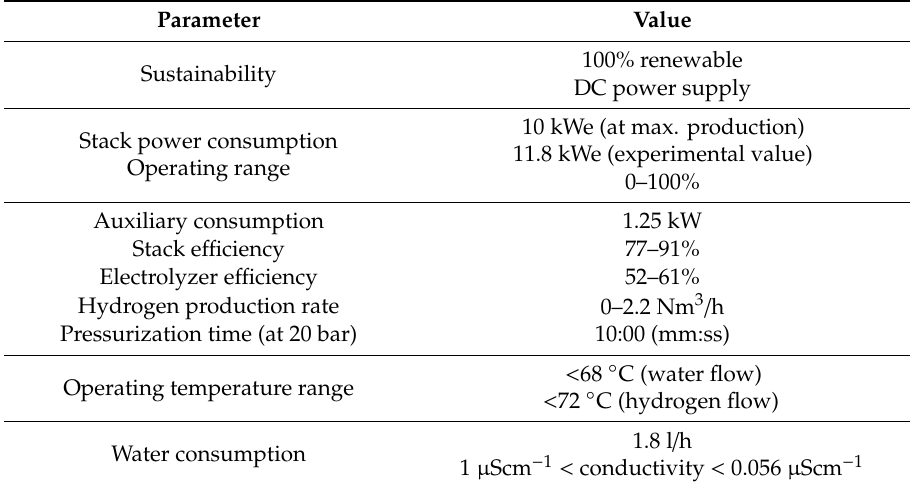
Table 6. Main characteristics of the developed PEM